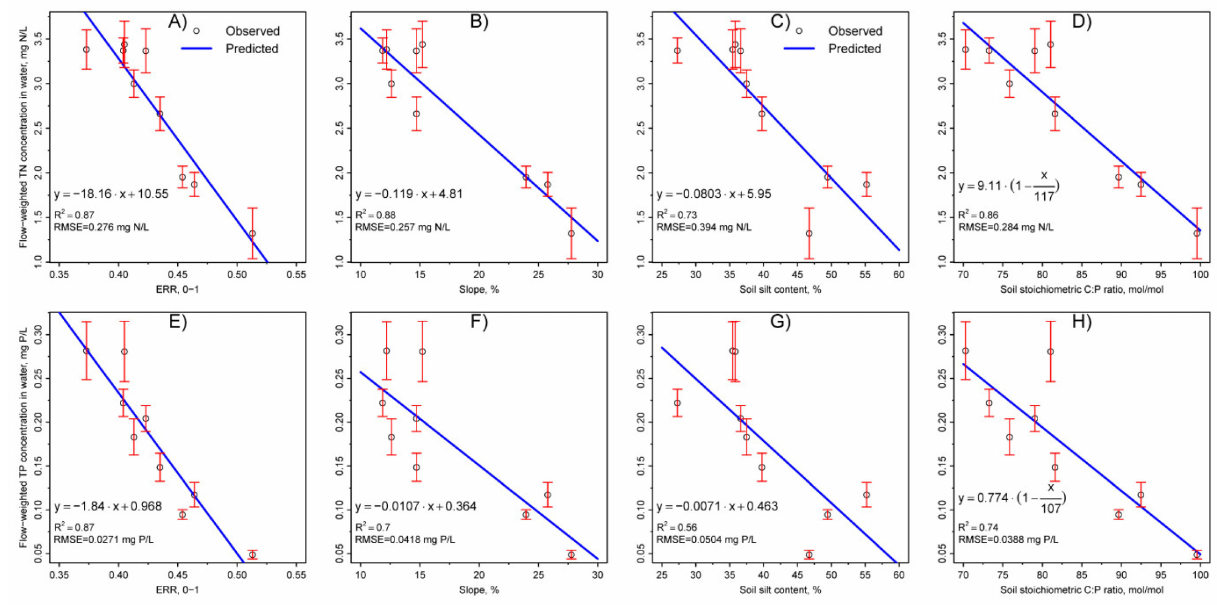
Figure 2. Relationships of the flow-weighted total nitrogen (TN) and total phosphorus (TP) concen- trations in outlet water with the elevation–relief ratio (ERR) ( A , E ), the slope ( B , F ), the soil silt content ( C , G ) and the soil stoichiometric ratio of carbon to phosphorus ( D , H ) in the nine catchments. The blue lines are the model fitting curves. The bars denote the standard errors of the observed 6-year flow-weighted TN and TP